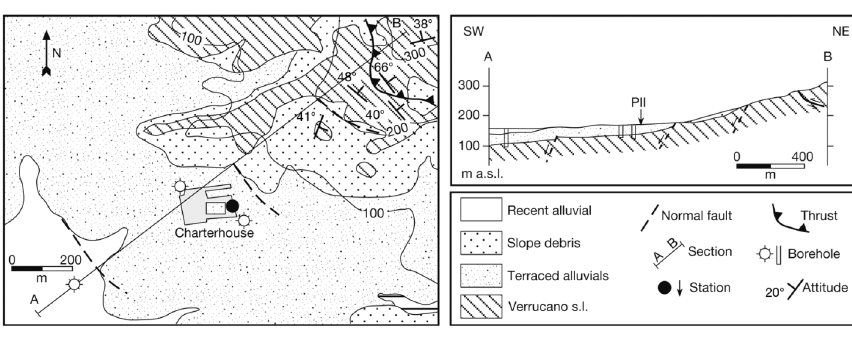
Fig. 10. Geological map and section at the site of the station PII